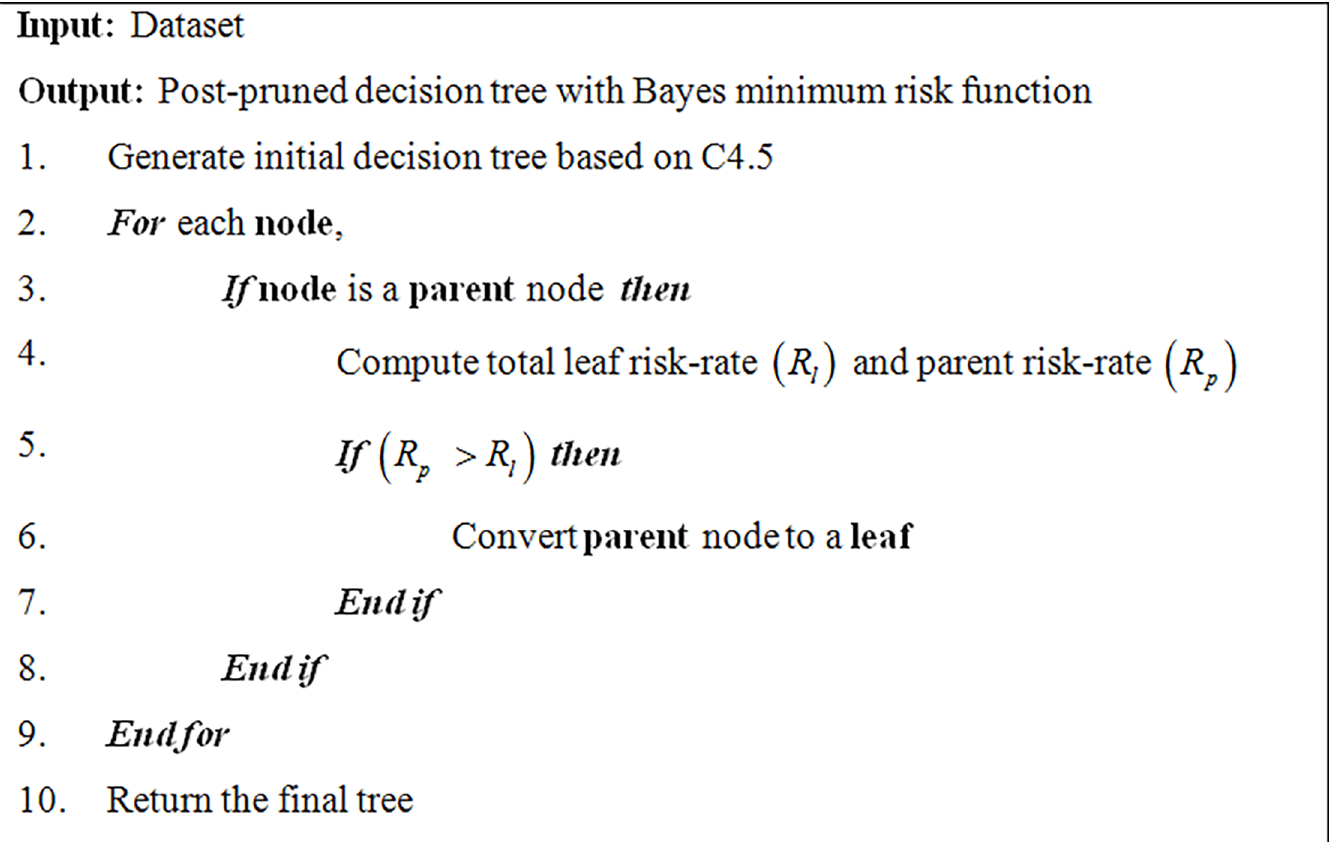
Fig 3. Proposed decision tree classification algorithm based on post-pruning with Bayes minimum risk.